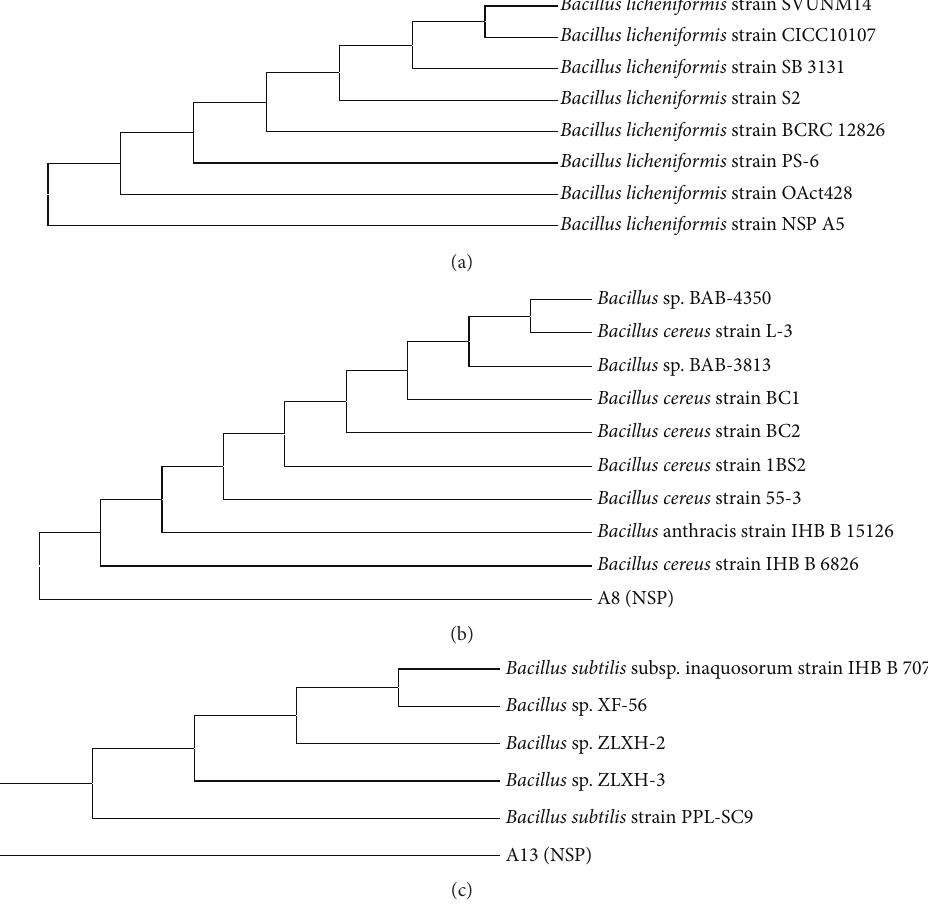
Figure 1: Phylogenetic analysis of the isolates based on 16S rDNA sequence analysis. (a) Phylogenetic tree of isolate NSPA5, (b) phylogenetic tree of isolate NSPA8, and (c) phylogenetic tree of isolate NSPA13.